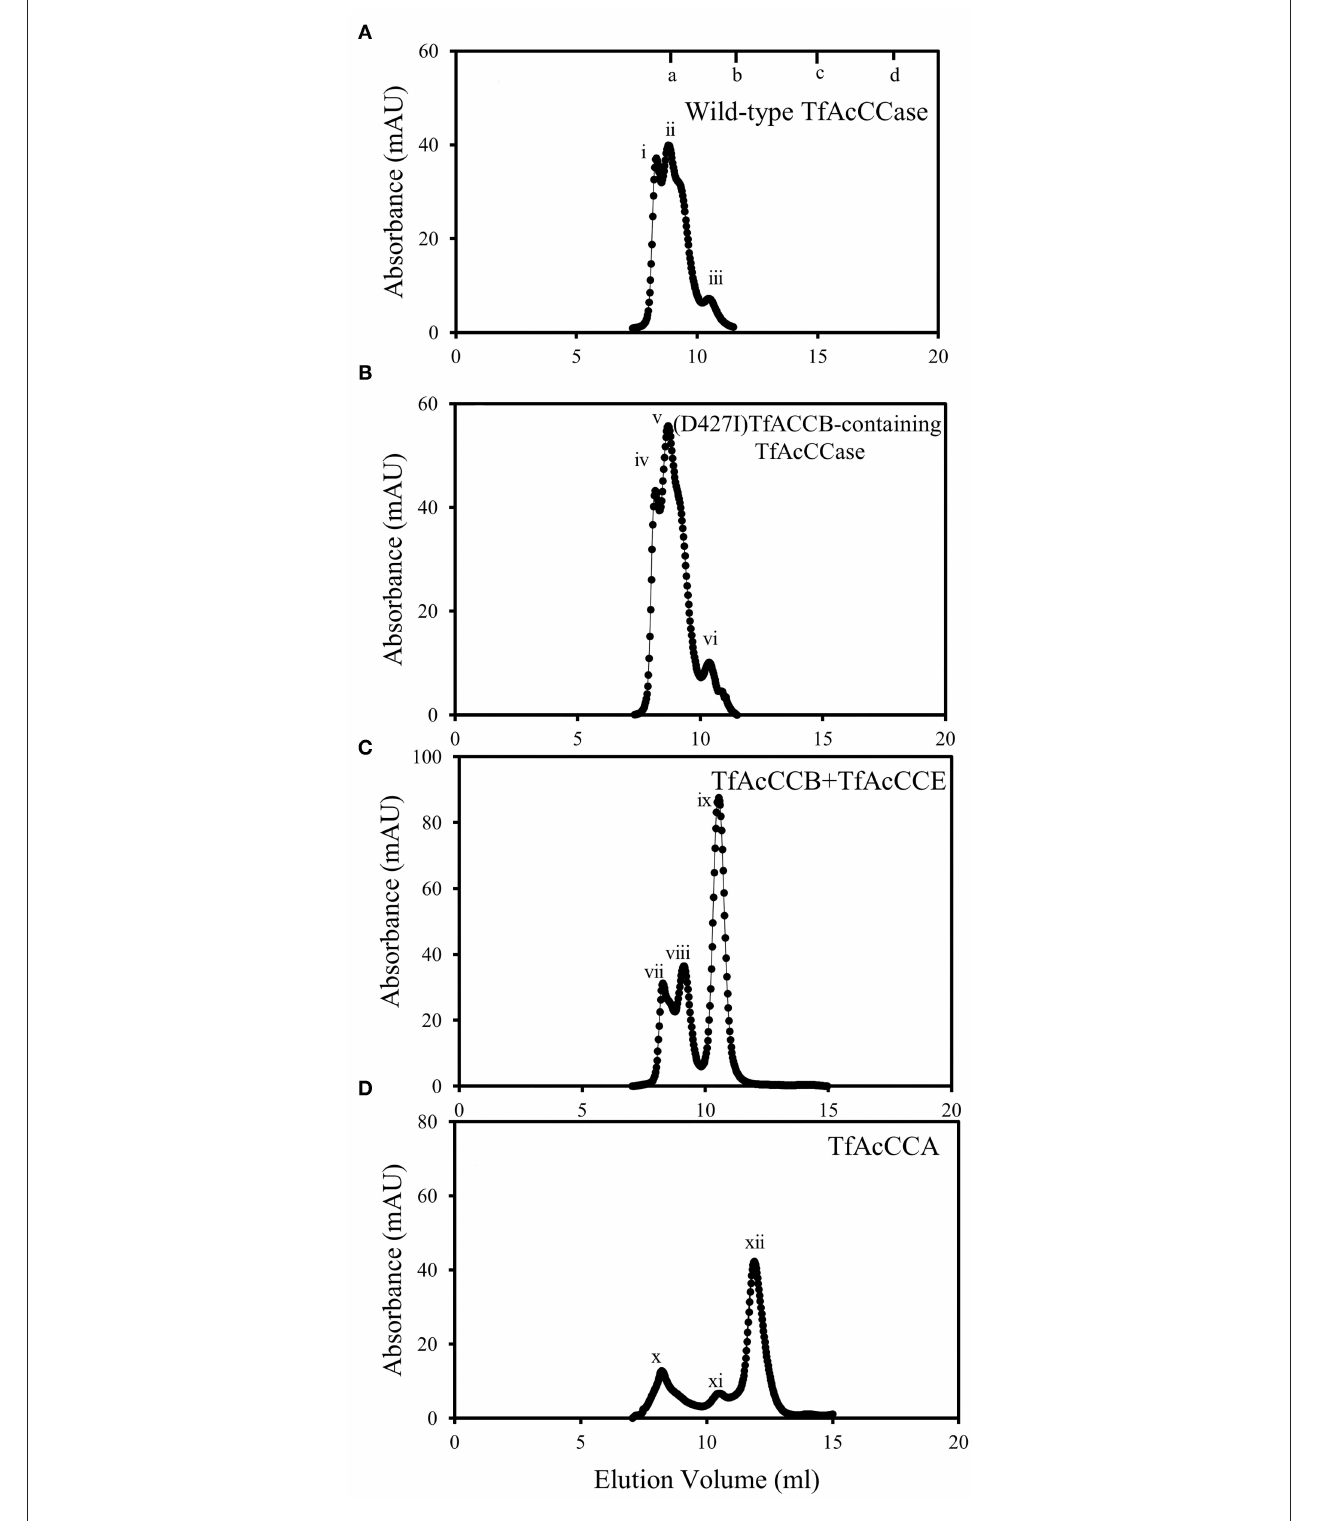
FIGURE 2 | Gel filtration FPLC analysis of reassembled TfAcCCase and sub-component complexes. All reassembled complexes were purified by using a nickel affinity column via a His-tag fused to one subunit, and the purified preparations were subjected to gel-filtration chromatography. The gel filtration column was calibrated by determining the elution volume of the standard proteins: (a) bovine thyroglobulin (670 kDa); (b) bovine γ -globulin (158 kDa); (c) chicken ovalbumin (44 kDa); (d) horse myoglobin (17 kDa): (A) reassembled wild-type TfAcCCase; (B) reassembled TfAcCCase using the D427I-mutant of the TfAcCCB subunit; (C) His-tagged TfAcCCB-TfACCE subcomplex; (D) His-tagged TfAcCCA.